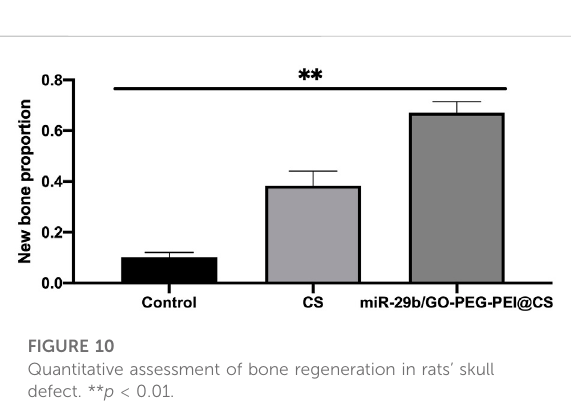
FIGURE 10 Quantitative assessment of bone regeneration in rats ’ skull defect. ** p <